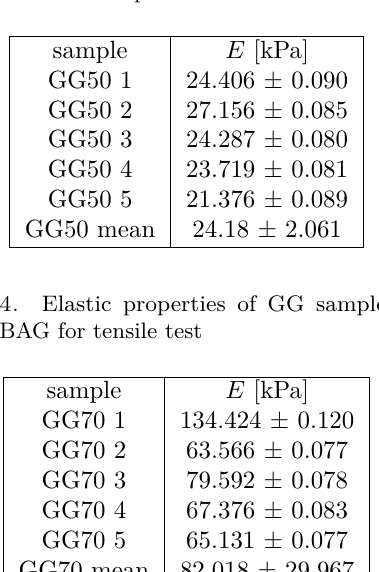
Table 3. Elastic properties of GG samples with 50 wt% BAG for compression test